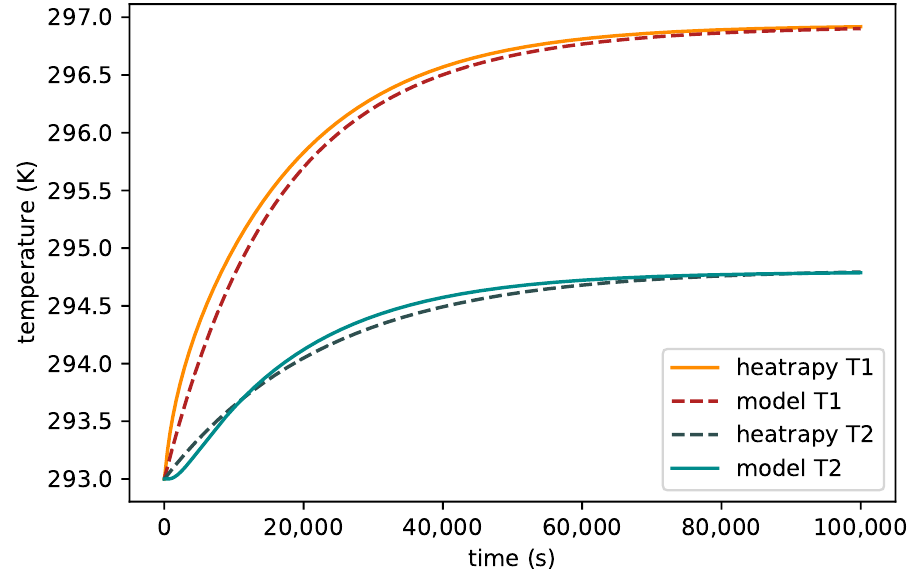
Figure 5. Temperature evolution using the developed model and the heatrapy simulations for a thermal circuit with two thermal resistances in parallel. The used thermal resistances were made of Al, Cu and Si solid materials.